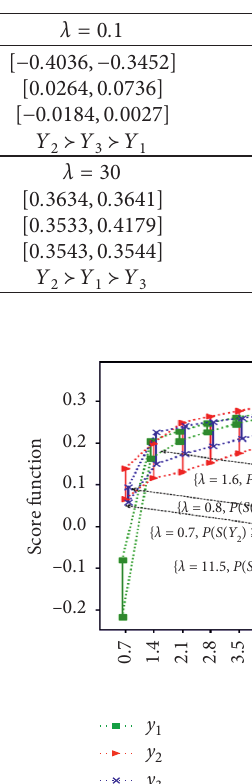
Table 8: Score values based on the GIVPHFHA operators.